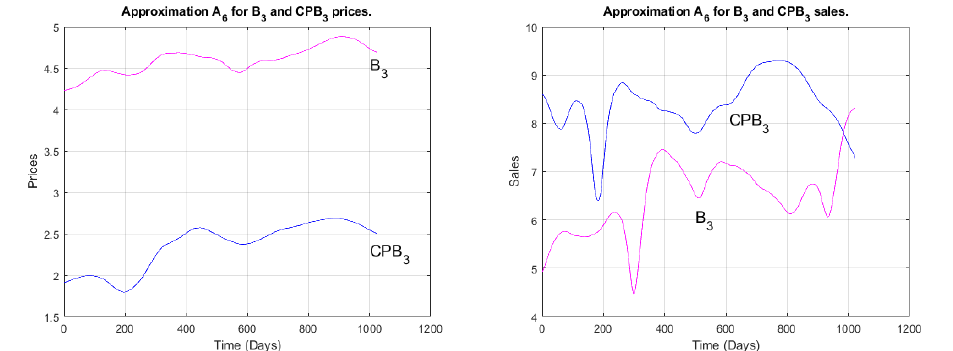
Figure 15. The wavelet approximation A 6 for B 3 and CPB 3 prices and sales at level